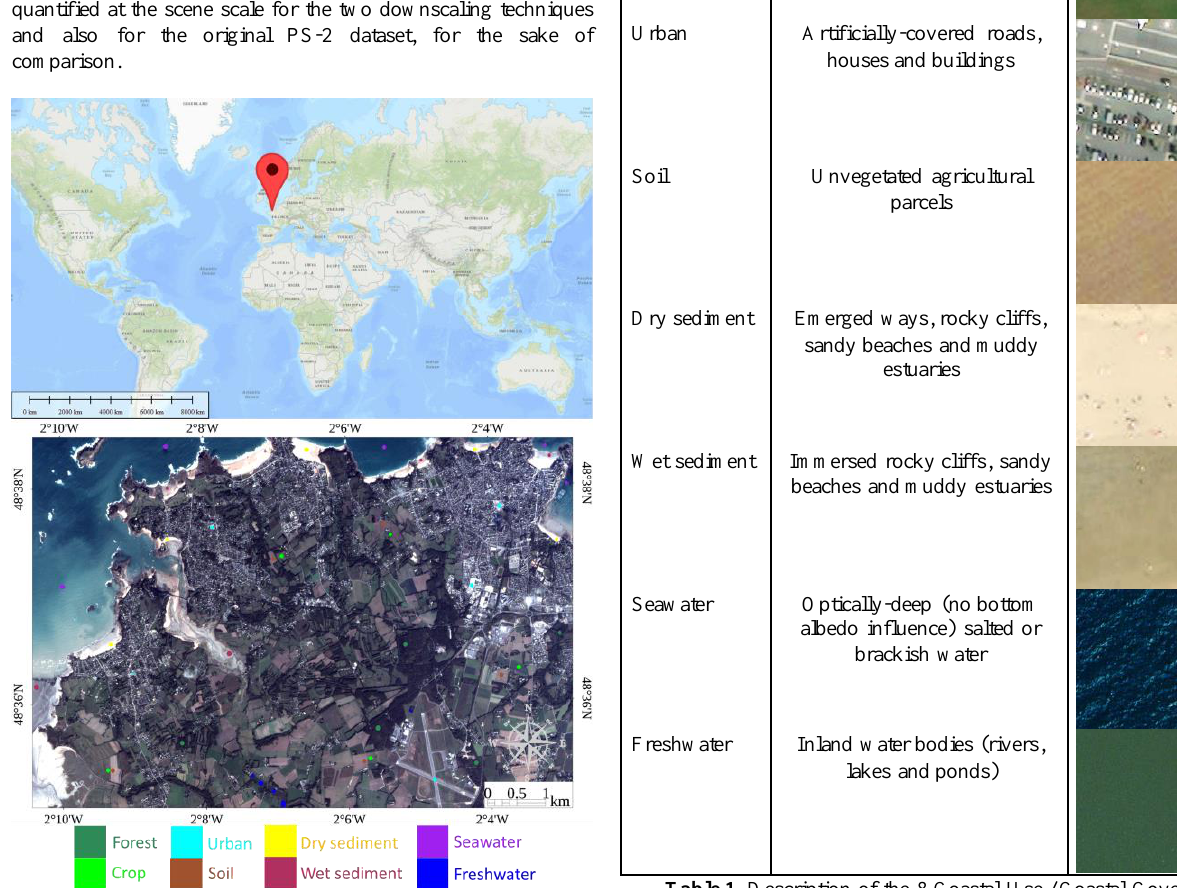
Figure 1 . Natural-coloured imagery of the study area based on a PlanetScope-2 surface reflectance imagery (3097 × 2124 pixels).